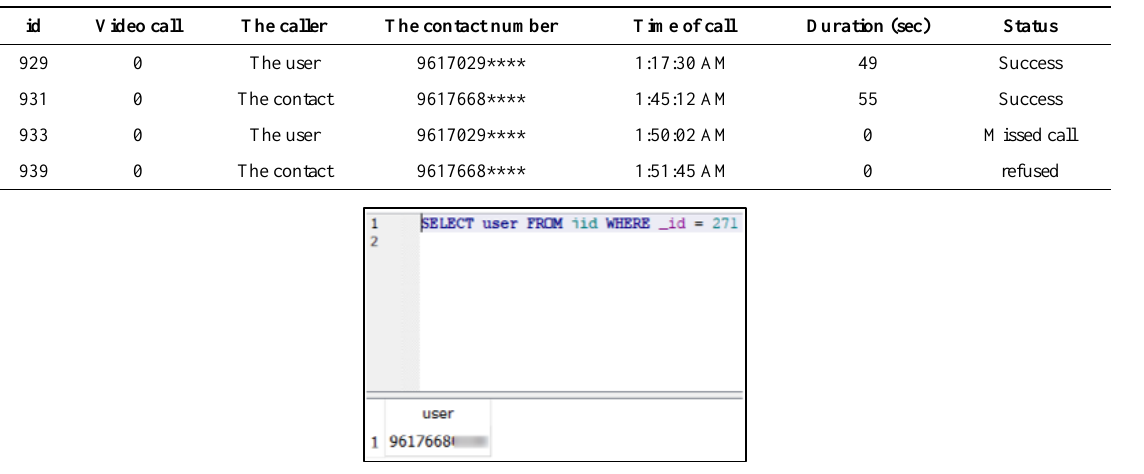
Table 11. Reconstruction of the call history